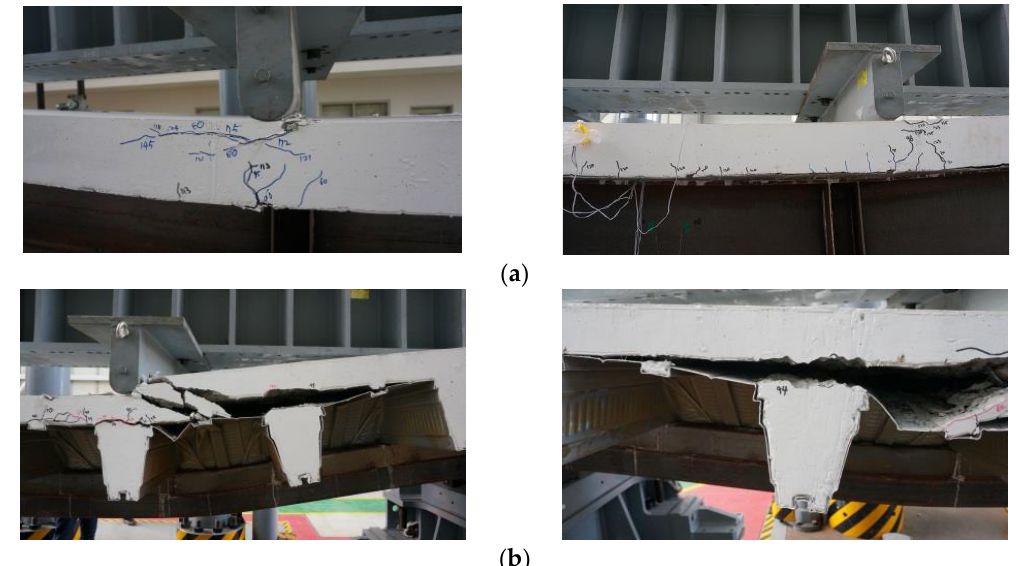
Figure 16. Ultimate failure modes of the fully composite specimens: ( a ) 738-WFC-X-X-TD; ( b ) 585- TFC-O-R1-DD. Table 13. Locations of neutral axis at failure of the fully composite specimens.